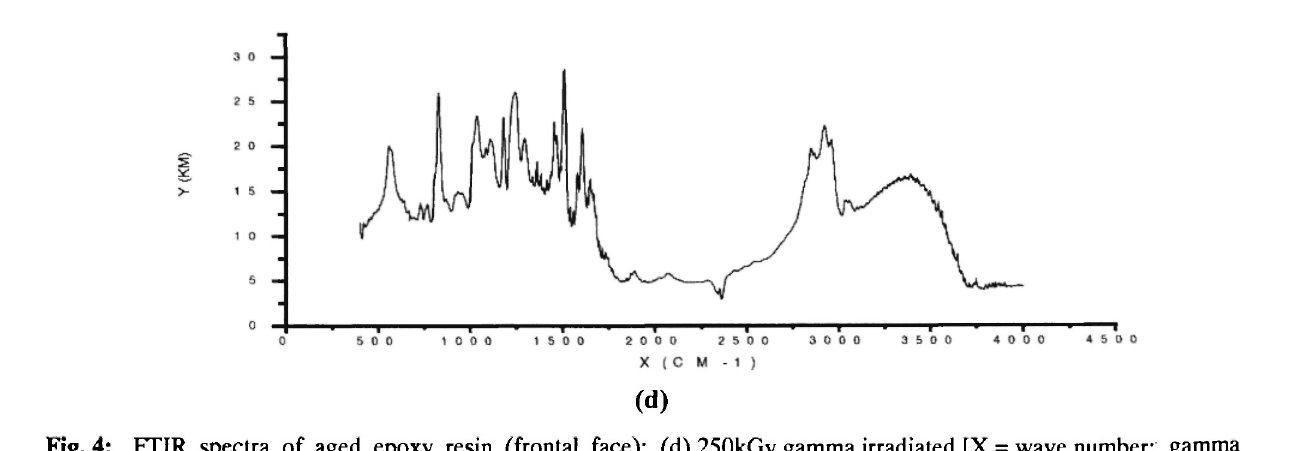
Fig. 4: FTIR spectra of aged epoxy resin (frontal face): (d) 250kGy gamma irradiated [X = wave number; gamma Y = absorbance/